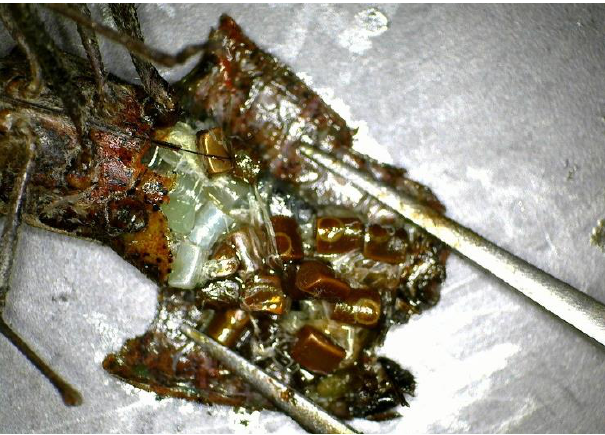
Figure 1. Dissected female with developed eggs.